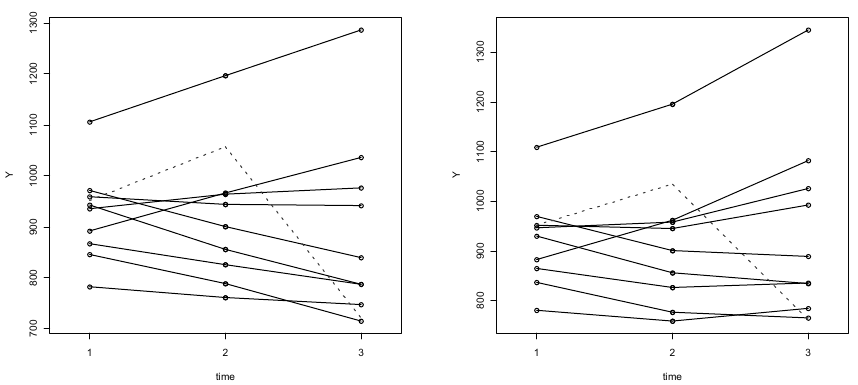
Figure 1 – Examples of quasi-linear trend (the dotted line segments are an outlier).